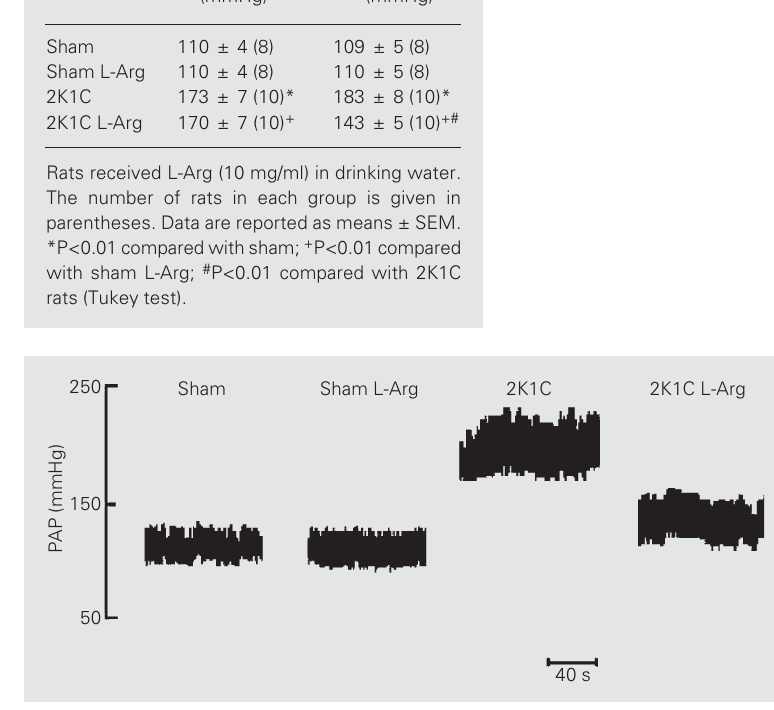
Figure 1. Typical recording of pulsatile arterial pressure (PAP) for the four experimental groups: sham (sham-operated), sham L-Arg (sham treated with L-arginine), two-kidney, one-clip (2K1C) control and 2K1C L-Arg-treated rats. The data are shown for 14 days of L-Arg